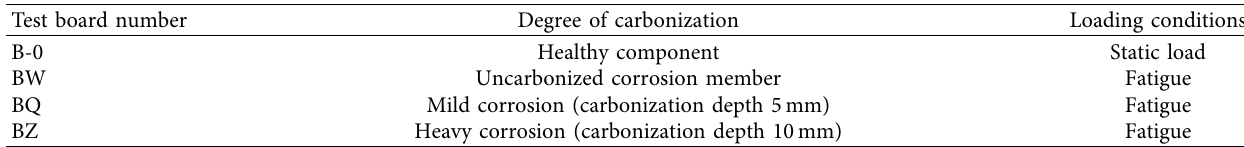
Figure 2: Modified carbonized corrosion device. Table 2: Carbonation corrosion design and loading methods.